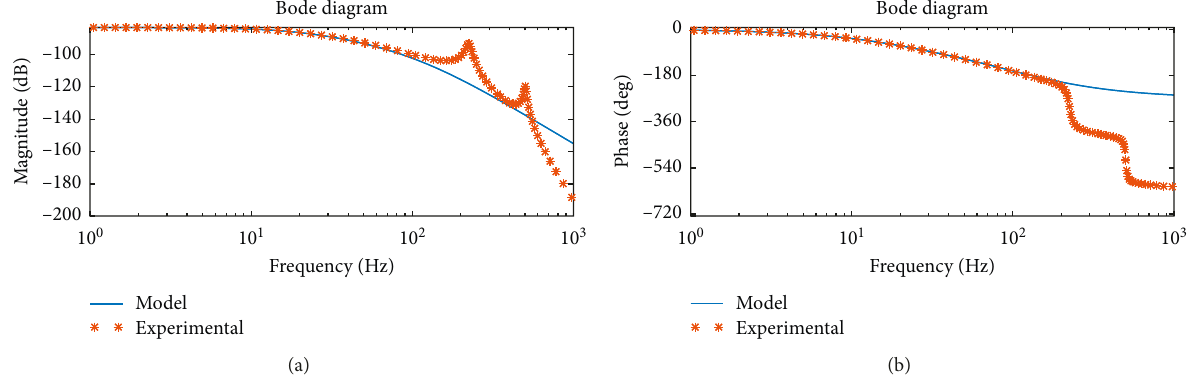
Figure 7: Amplitude-frequency and phase-frequency characteristics.